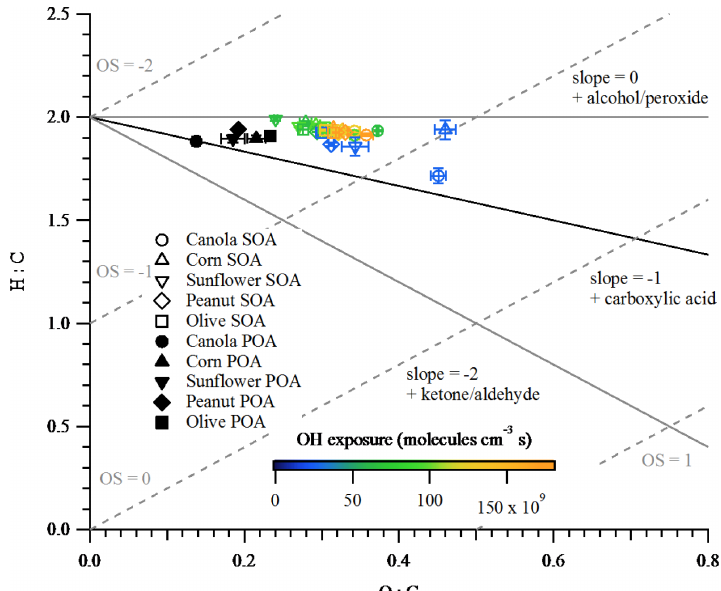
Figure 8. Van Krevelen diagram of POA and SOA from different heated cooking oils. Error bars represent the standard deviations (1 σ ). SOA data are colored by OH exposure. Average carbon oxidation states from Kroll et al. (2011) and functionalization slopes from Heald et al. (2010) are shown for